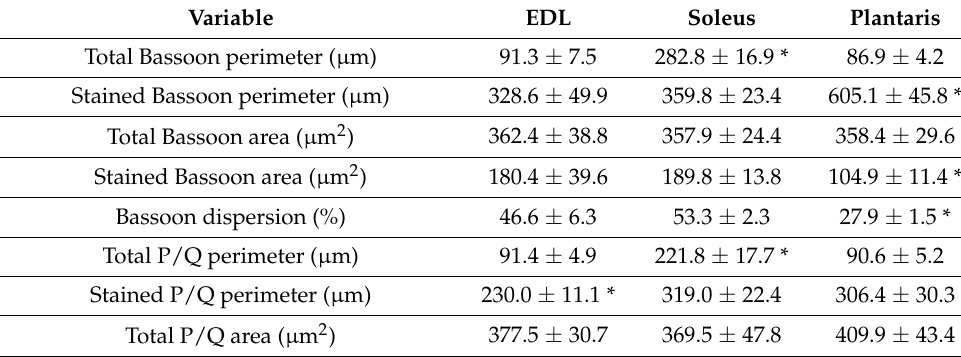
Table 2. Subcellular morphology of NMJs in muscles of